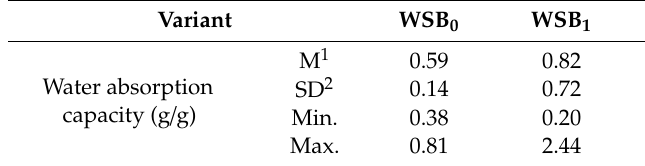
Table 5. Water absorption capacity of the filtering nonwovens WSB 0 and WSB 1 . Variant